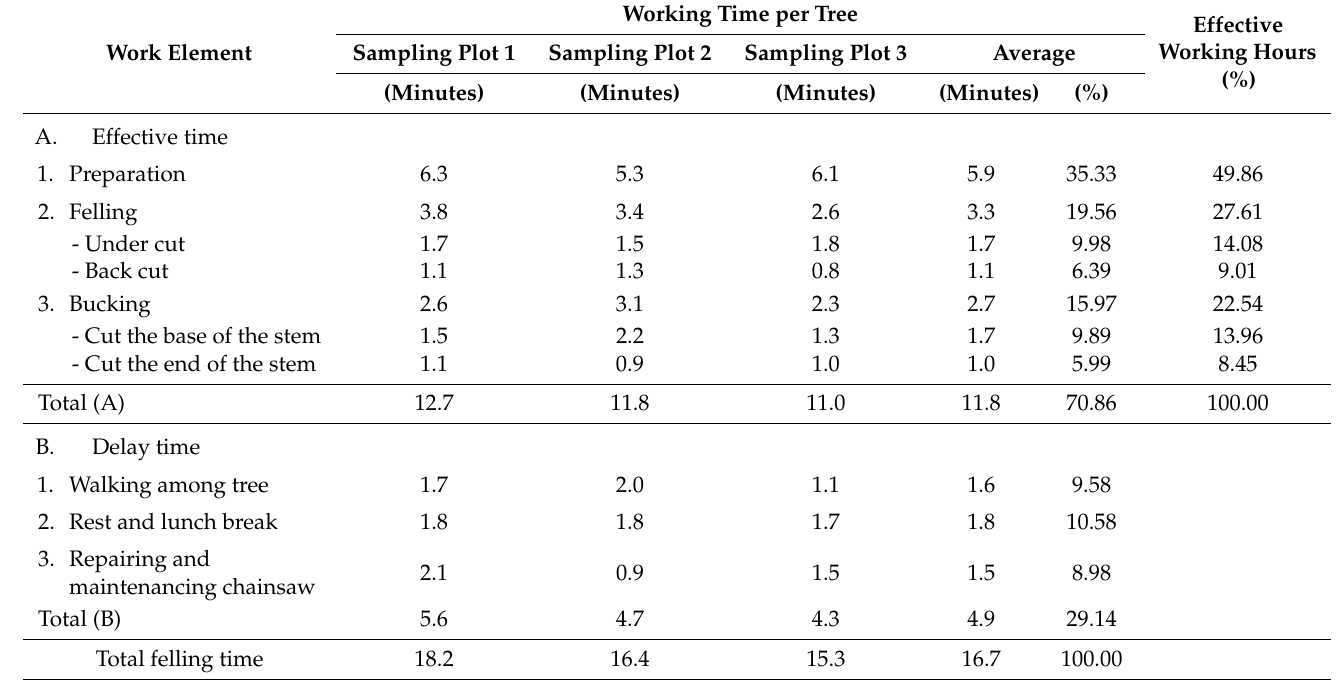
Table 1. Resume of working time of felling in natural forest, West Papua, Indonesia.